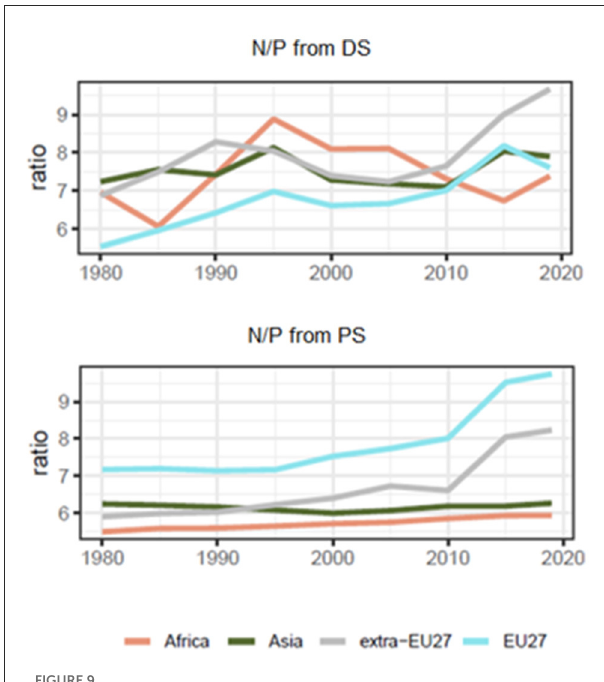
FIGURE9 N/P ratio for N inputs by continents. DS: diffuse sources; PS: point